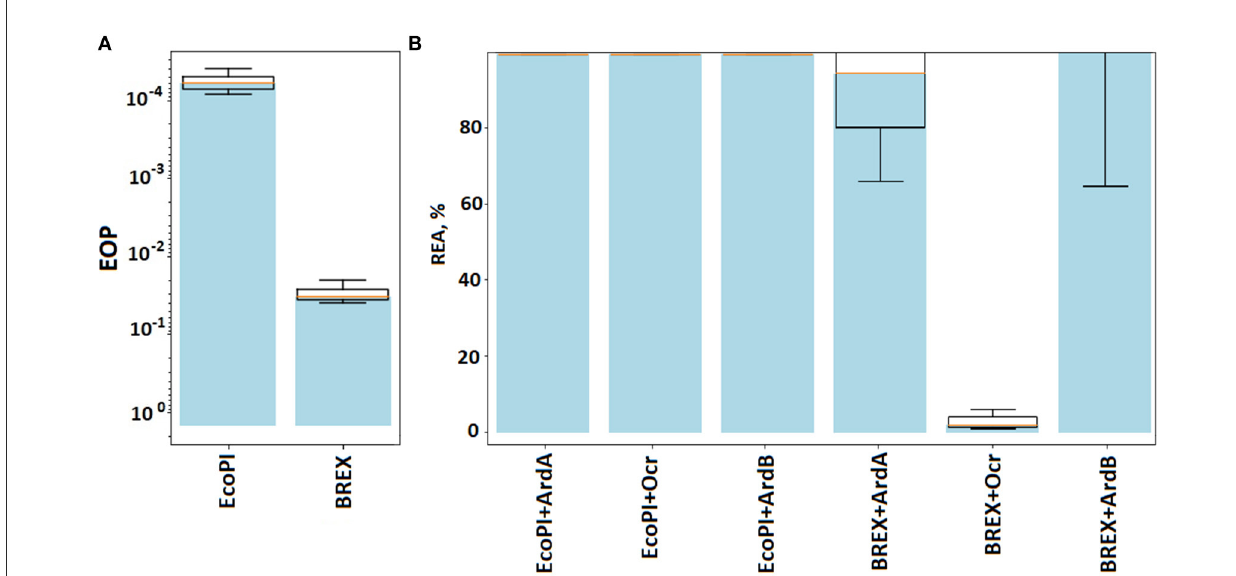
FIGURE4 The efficiency of defense provided by BREX and RMIII (EcoPI) systems. (A) Results of the λ 0 phage plaquing (EOP) on a lawn of E. coli cells containing BREX or RMIII (EcoPI) defense systems of gram-negative bacteria. Columns: EcoPI – TG1pBTB_EcoPI and BREX – TG1pBREX. (B) Antirestriction activity of ArdA, ArdB, and Ocr proteins. Residual endonuclease activity (REA) represents the activity of endonuclease in the presence of antirestriction proteins. Columns: EcoPI + ArdA – TG1pBTB_EcoPIpUCArdA(pSR3), EcoPI + ArdB(prha) – TG1pBTB_EcoPIpArdBRham_AmpR, EcoKI – TG1pACYCEcoKI, BREX + ArdA – TG1pBREXpUCArdA(pSR3), BREX + ArdB(prha) – TG1pBREXpArdBRam, EcoPI – TG1pBTB_EcoPI, EcoPI + Ocr – TG1pBTB_EcoPIp15ara:ocr, and BREX + Ocr –